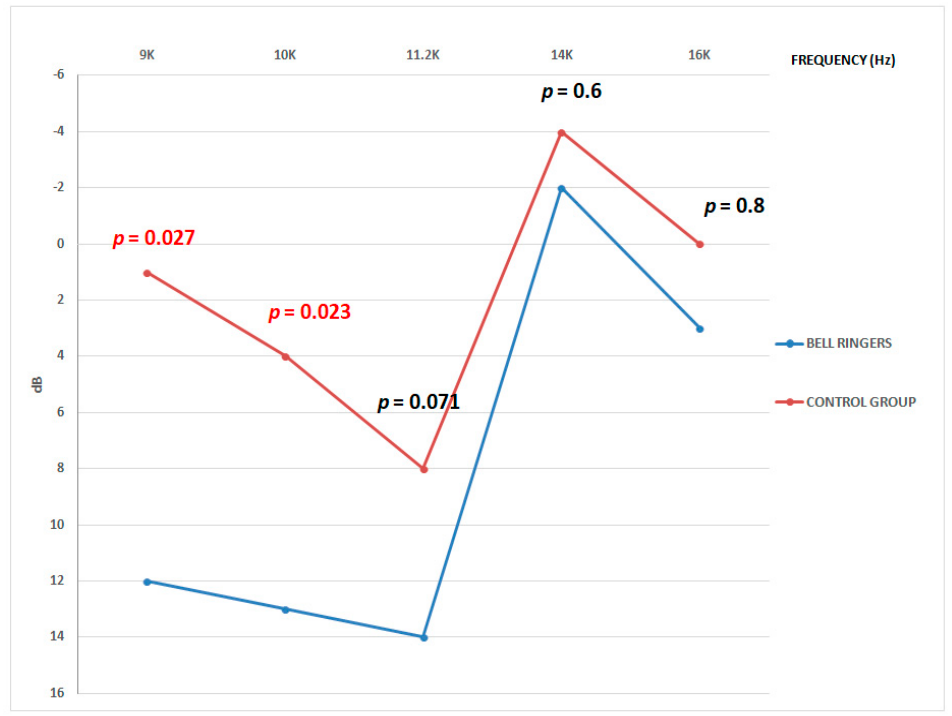
Figure 15. Average hearing threshold obtained from the audiometry with age correction for high frequencies.